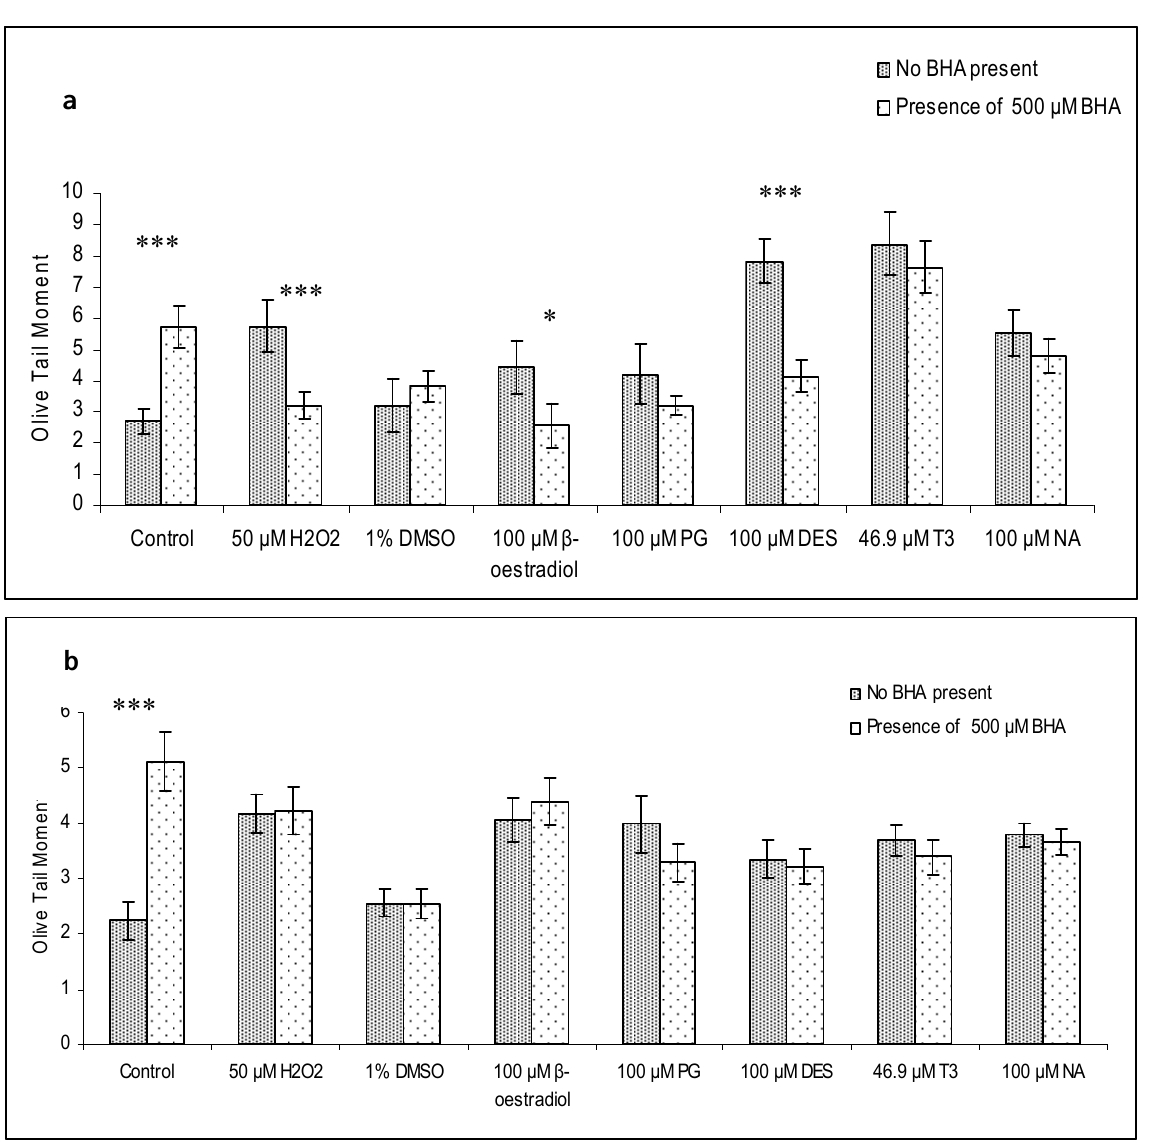
Figure 1. The Olive Tail Moment values f ο r lymphocytes (a) and sperm (b) treated with oestrogenic compounds or Η Ο for 30 min at 37 °C in the presence and absence of BHA 2 2 (500 μ M). The figures express the mean of the values obtained from 7 independent experiments (n = 7 different donors) in (a) and 5 independent experiments (n = 5 different donors) in (b). For (a) the average age was 27.57 ± 2.41 and for (b) the average age was 30.80 ± 2.35. Normality of the data was evaluated with the Shapiro-Wilks test. Data were normally distributed. The Student’s T-test was applied. For statistical interpretation of the data, treatment in the absence of BHA was compared to treatment with the same compound with its presence. The levels of significance are included: n.s. not significant; *p ≤ 0.05; **p ≤ 0.01 and ***p ≤